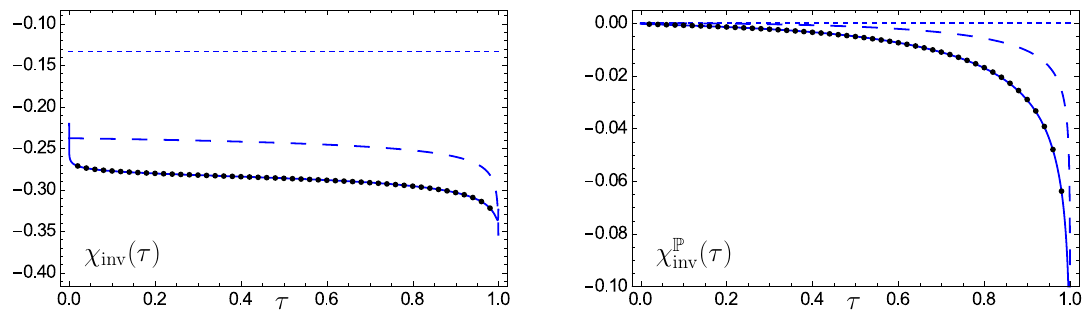
( (cid:28) ) (right panel) for (cid:11) s =(cid:25) = 0 : 1. The inv